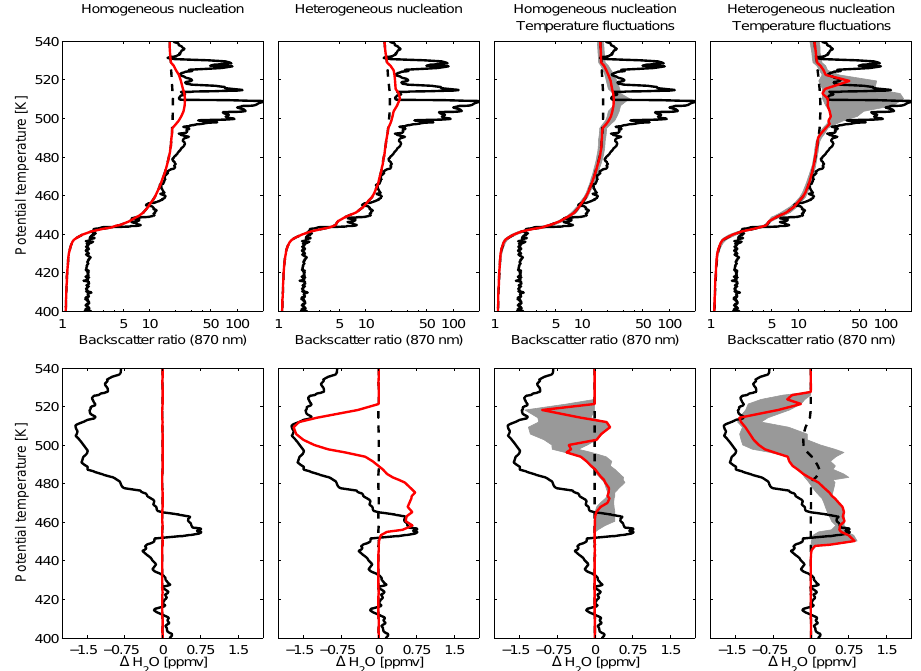
Fig. 6. Comparison between measured and simulated profiles of backscatter ratios (BSR) for S1 (upper row) and water vapor mixing ratios for S2 (lower row). Mixing ratios are expressed as deviation from the climatological mean water vapor profile. The four different model scenarios are the same as in Fig. 5. Black line: COBALD (upper row) and CFH (lower row) measurements. Gray shaded area: variations caused by different small-scale temperature fluctuations modeled by an ensemble with 10 members. Red line: model results for the best fluctuation member shown in Figs. 3–5. Dashed line: model results obtained without temperature correction (as shown in Fig.